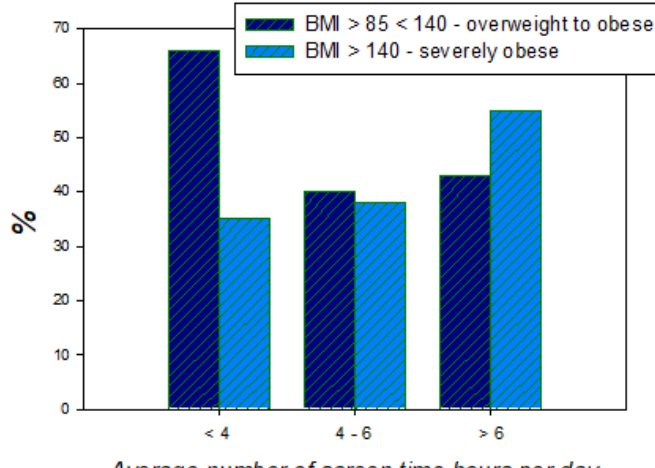
Figure 4. Results of a survey from the USA revealing the link between the severity of obesity and the number of screen time hours per day in children treated for obesity in di ff erent hospitals across the country